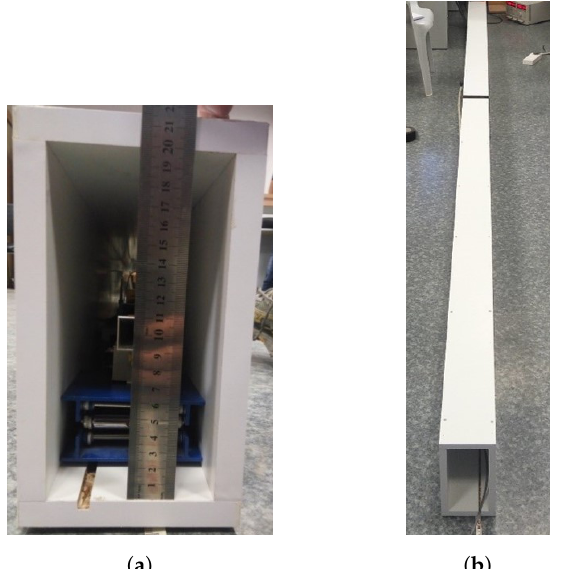
Figure 10. Downscaled tunnel experiment setup in the laboratory. ( a ) Cross section of the tunnel. ( b ) Down scale tunnel.